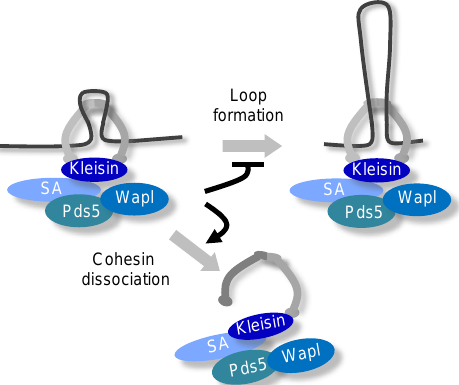
Figure 6. Proposed functions of Pds5/Wapl in the regulation of cohesin. PDS5/WAPL inhibits loop formation and promotes cohesin dissociation from chromatin. Conformational changes or unknown regulatory factors may be involved at each step to modulate the functions of Pds5 and Wapl.